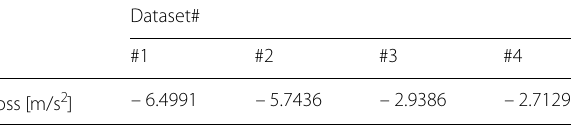
Table 4 Loss of Regression w/o L2 normalization after